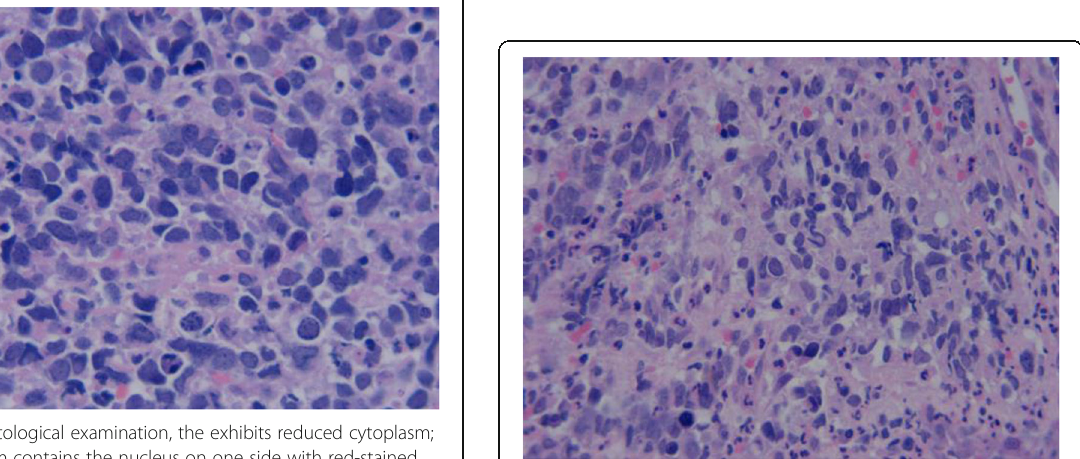
Fig. 4 In some areas, as the cells differentiate, the acidophilic nature of the cytoplasm gradually increases. The cells appear fusiform, banded, or